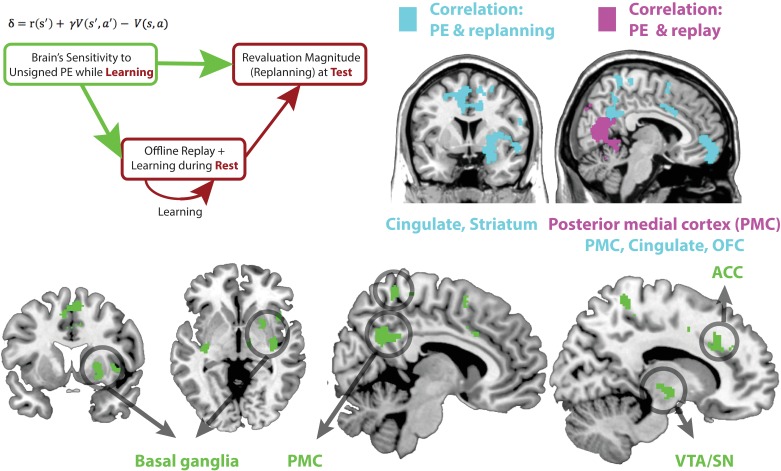
(Top left) Schematic of a theoretical account of revaluation.We propose that neural sensitivity to reward prediction errors during learning ‘tags’ or ‘prioritizes’ memories for replay during later rest periods. Replay during rest, in turn, allows the comparison of past policy with new simulated policy and updating of the past policy when needed. (Top right) Regions where sensitivity to unsigned PE in Revaluation blocks correlates with subsequent replay during rest (extent threshold p < 0.005, cluster family-wise error [FWE] corrected, p < 0.05, shown in purple) and revaluation behavior (extent threshold p < 0.005, cluster FWE corrected, p < 0.05, shown in blue). (Bottom) Green reveals the conjunction of regions where sensitivity to unsigned PE in Revaluation blocks correlates with subsequent replay during rest (extent threshold p < 0.005, cluster FWE corrected, p < 0.05) and revaluation behavior (threshold p < 0.005, cluster FWE corrected, p < 0.05) in those blocks; the conjunction is shown at a p < 0.05 threshold. We found that the sensitivity of broad regions in the basal ganglia, the cingulate cortex (including the ACC), and the posterior medial cortex (precuneus) to unsigned prediction errors (signaling increase in uncertainty) correlated with both future replay during rest as well as subsequent revaluation behavior. See Tables 1 and 2 for coordinates.